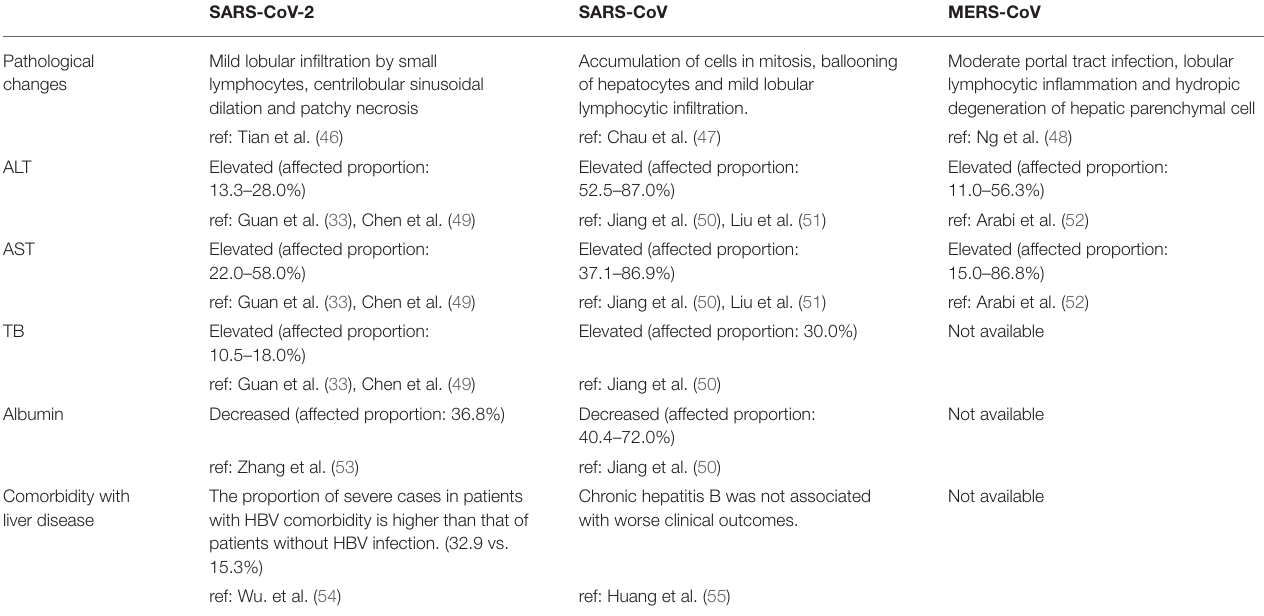
TABLE 1 | The manifestations of coronavirus-induced liver injury. SARS-CoV-2 SARS-CoV MERS-CoV Pathological